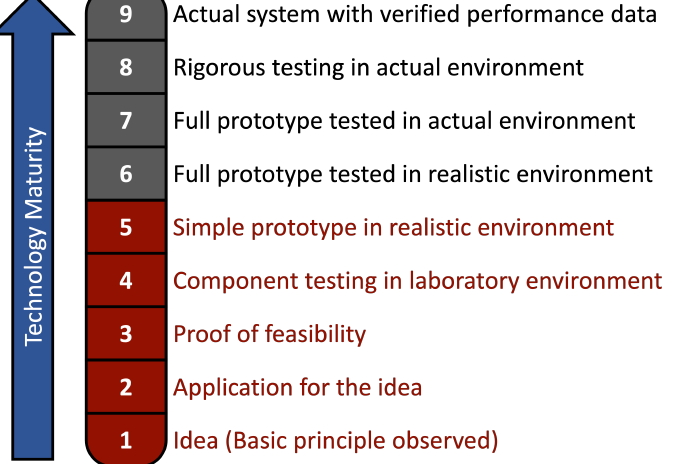
Figure 36. Technology Readiness Level (TRL) for the developed contribution in this